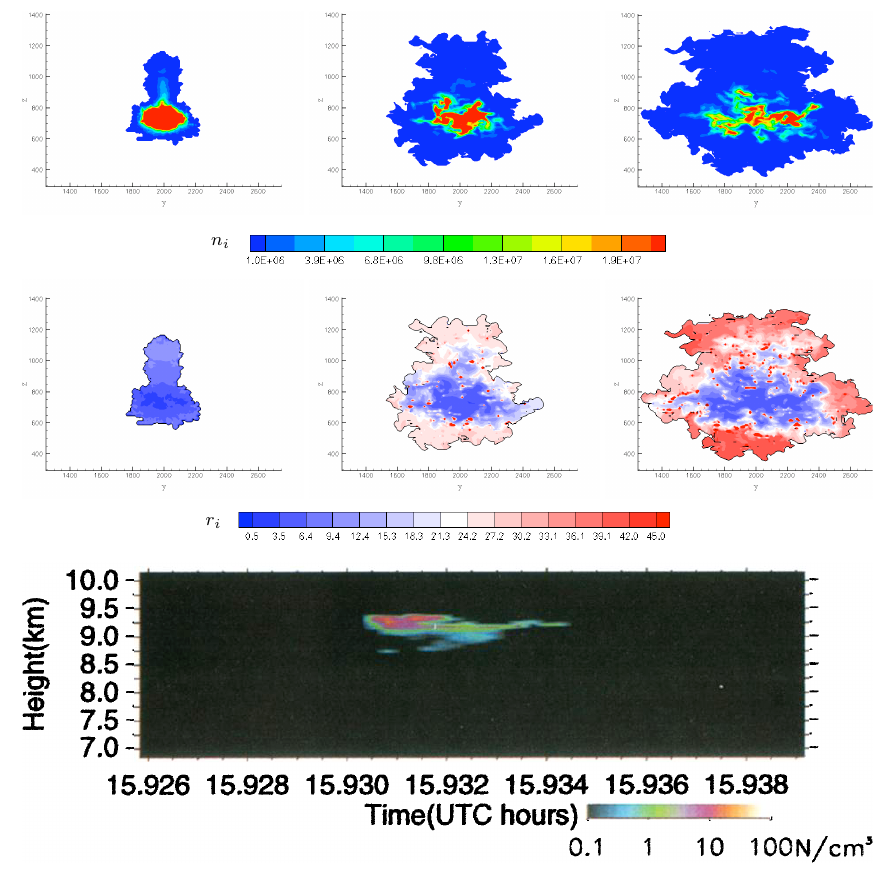
Fig. 17. Evolution of particle number density n p ( m − 3 ) (top panels) and particle radius r i (µm) (middle panels) averaged in the axial direction during the late dissipation regime (run D 1). From left to right: t = 320s, 1120s and 2120s. The red dots in the radius plots bottom figures are post-processing artifacts resulting from the assumption of (grid-cell) monodisperse size distribution in regions of low particle number density (particle radius is obtained from n p and ρ i using Eq. 1). The bottom panel shows airborne lidar data of a young contrail reported by Spinhirne et al. (1998). Time units in the horizonatal axis can be translated into spatial units using the flight speed of the aircraft, 200m /